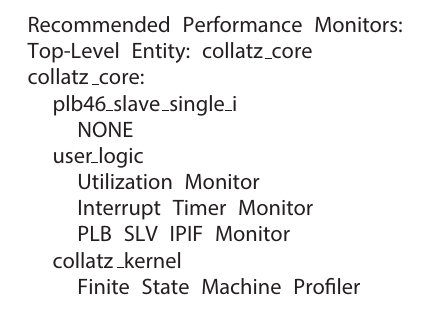
Figure 7: Sample output of performance monitor recommendation